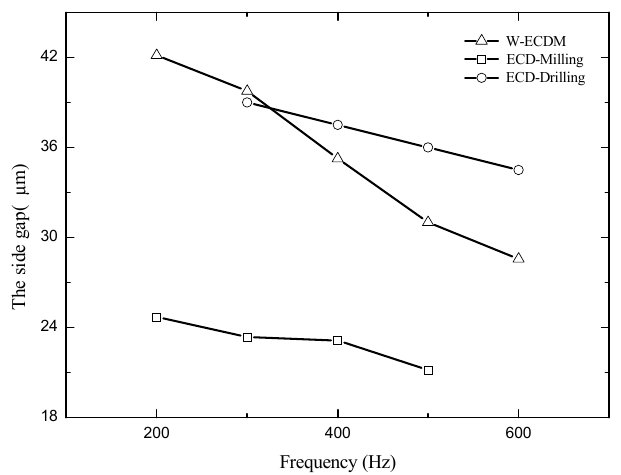
Figure 7. Effect of frequency on side gap.